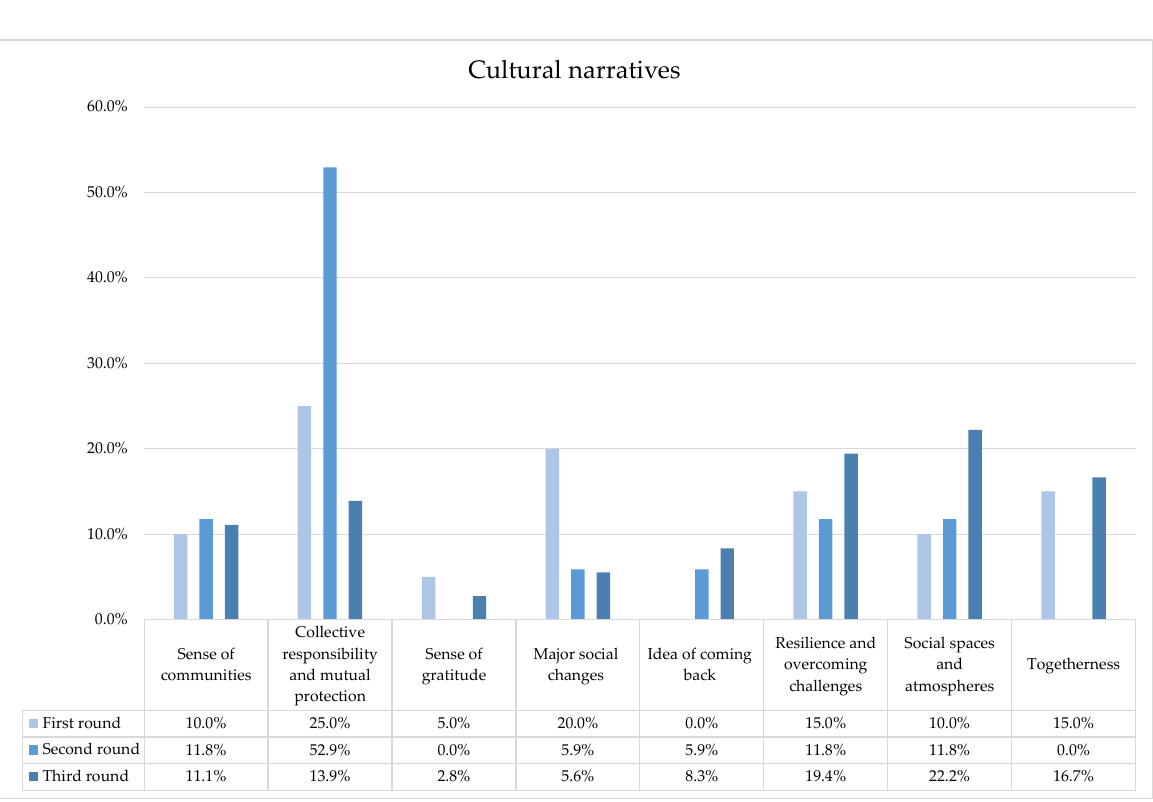
Figure 1. Percentage distribution of spots for each cultural narrative across the three phases of the Italian institutional health campaign during the COVID-19 pandemic.